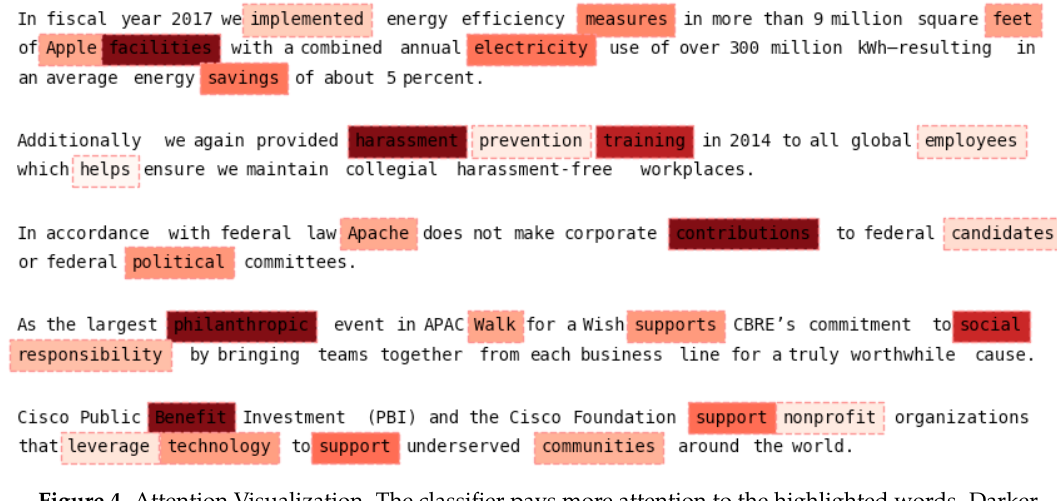
Figure 4. Attention Visualization. The classifier pays more attention to the highlighted words. Darker color implies higher attention